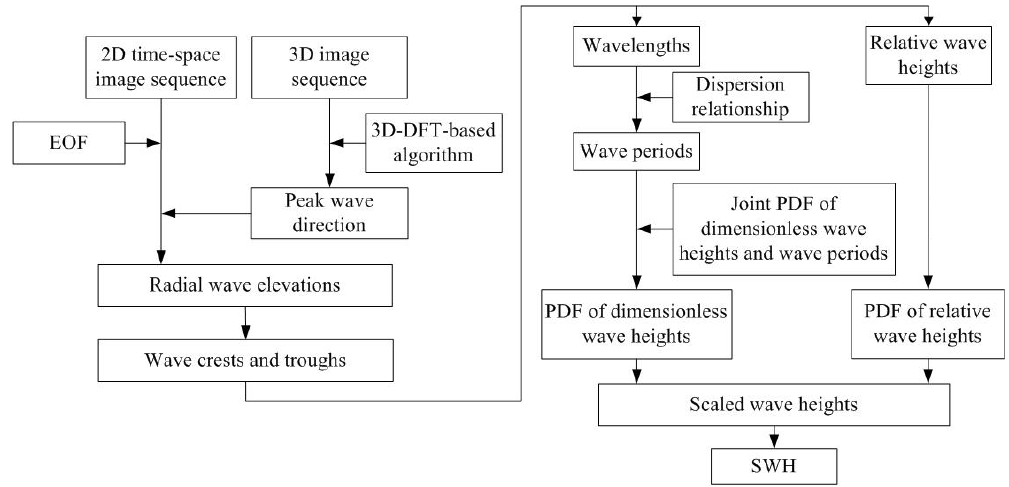
Figure 13. Basic steps of the joint- probability distribution function (PDF)-based